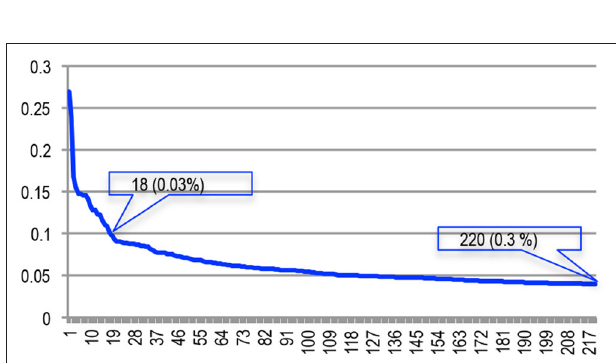
FIGURE 30 | Similarity scores of the couples detected as